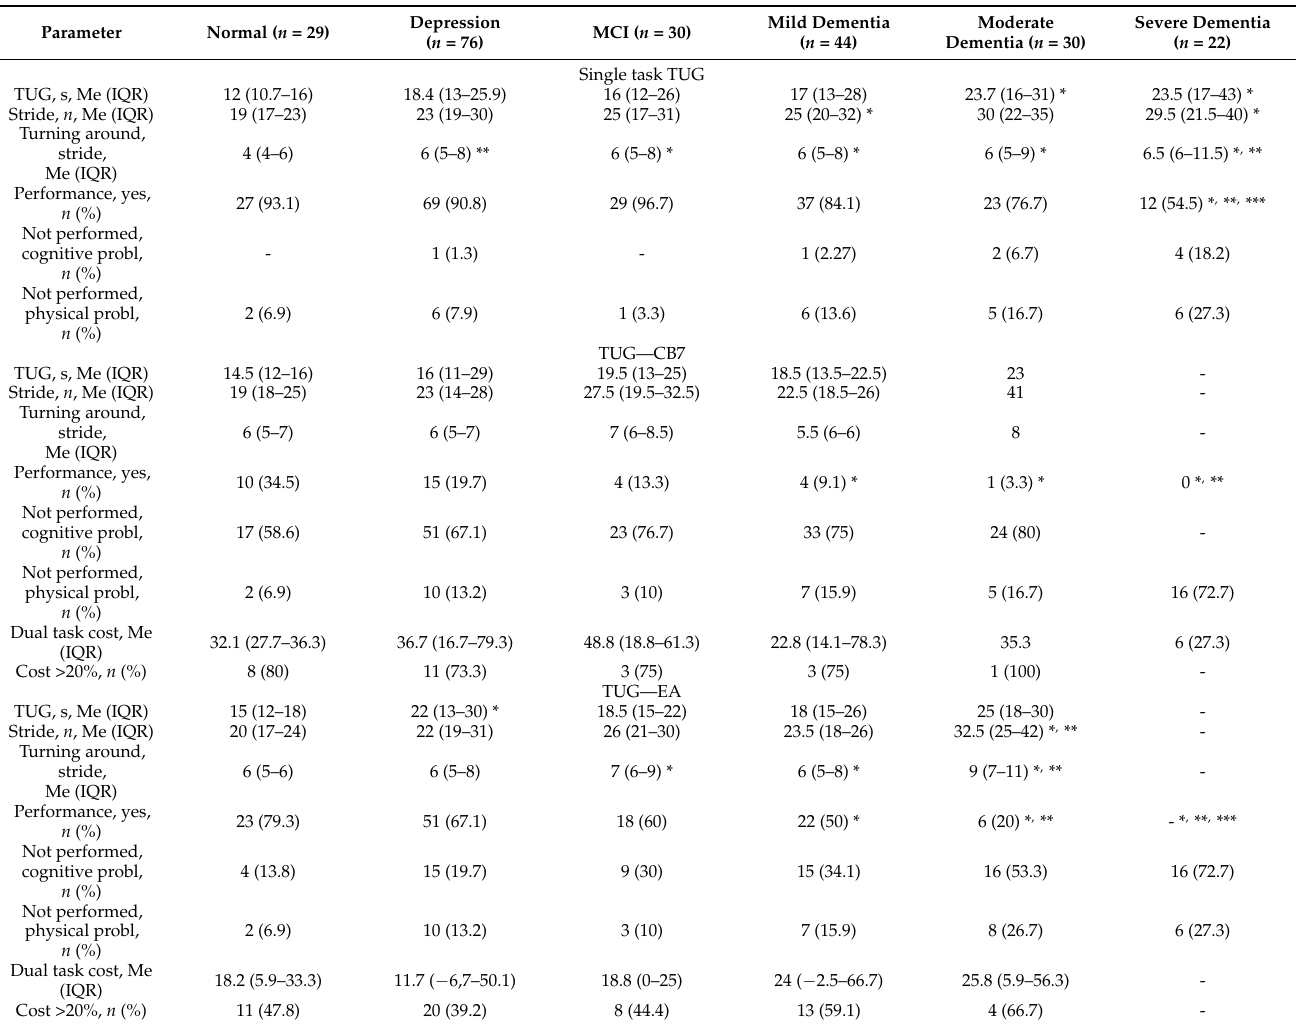
Table 2. Dual task gait test results in different cognitive states of